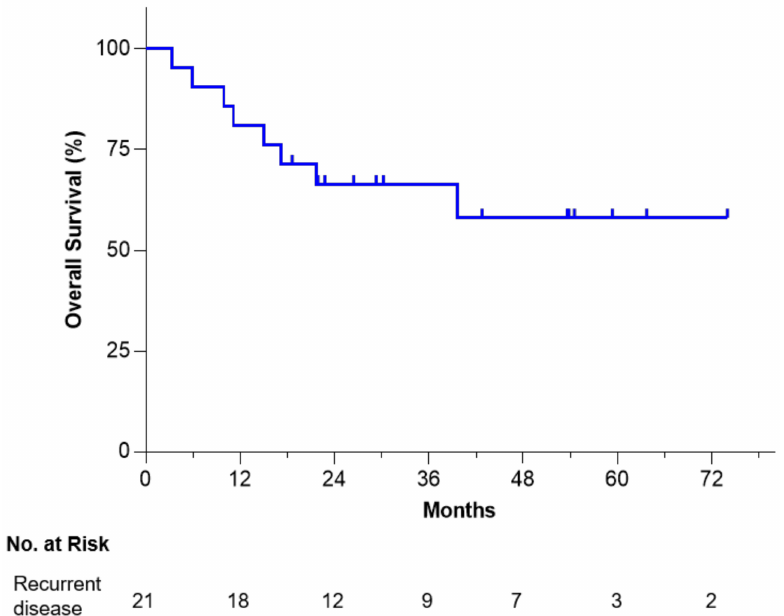
Figure 1. OS of Vigil-treated recurrent/refractory ovarian cancer patients from time of